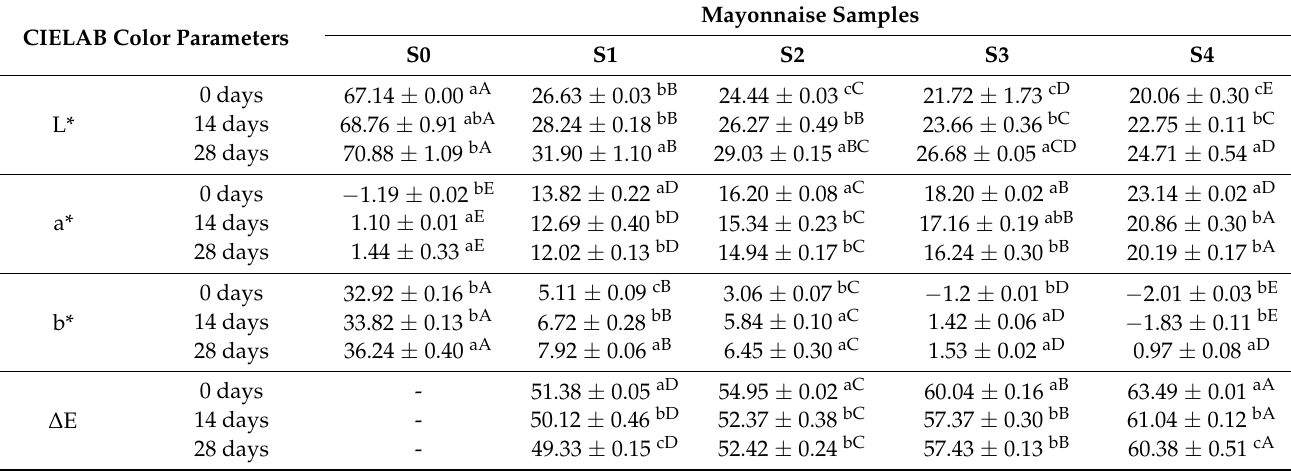
Table 3. The CIELAB color parameters of mayonnaise samples enhanced to varying degrees with BPP.